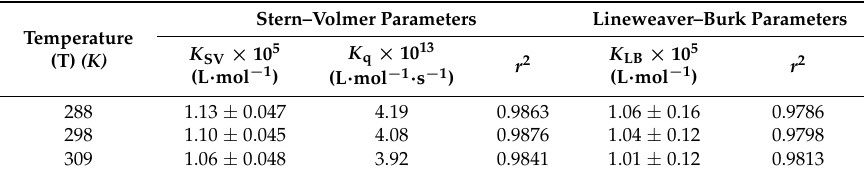
Figure 5. Plots of log [( F 0 − F )/ F ] vs. log [ Q ] for the compound 3- BSA interaction at different temperatures.